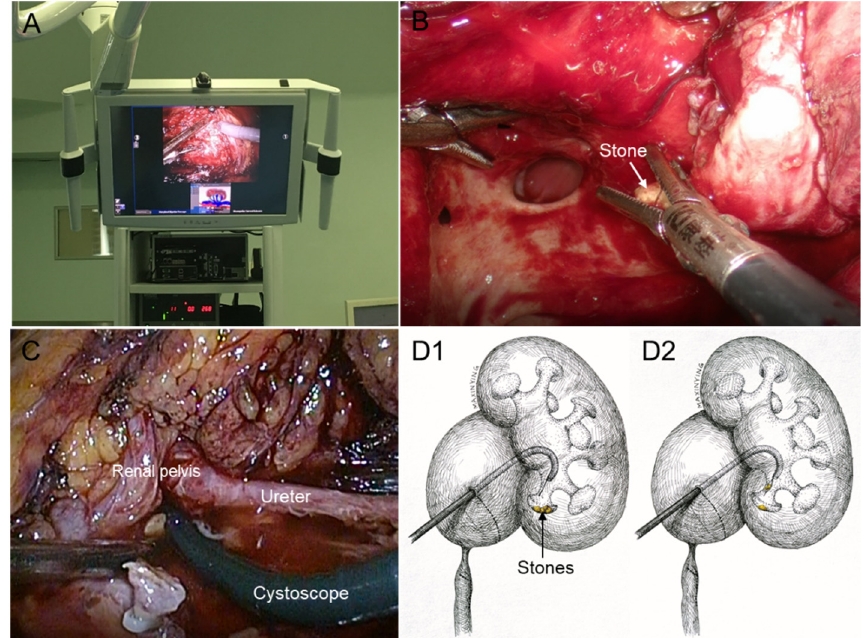
Figure 3. Concomitant procedures of renal calculi removal. ( A ) 3D CT reconstruction model was displayed on the surgical viewing screen for intraoperative navigation and localization; ( B ) the renal calyceal stone was extracted using laparoscopic forceps; ( C ) the flexible cystoscope was introduced into the renal pelvis through an oblique incision on the lower pole of the pelvis above the strictured site of ureteropelvic junction; ( D ) the subrenal calyx stones were extracted by flexible cystoscope (D1, stone exploration; D2, stone extraction).